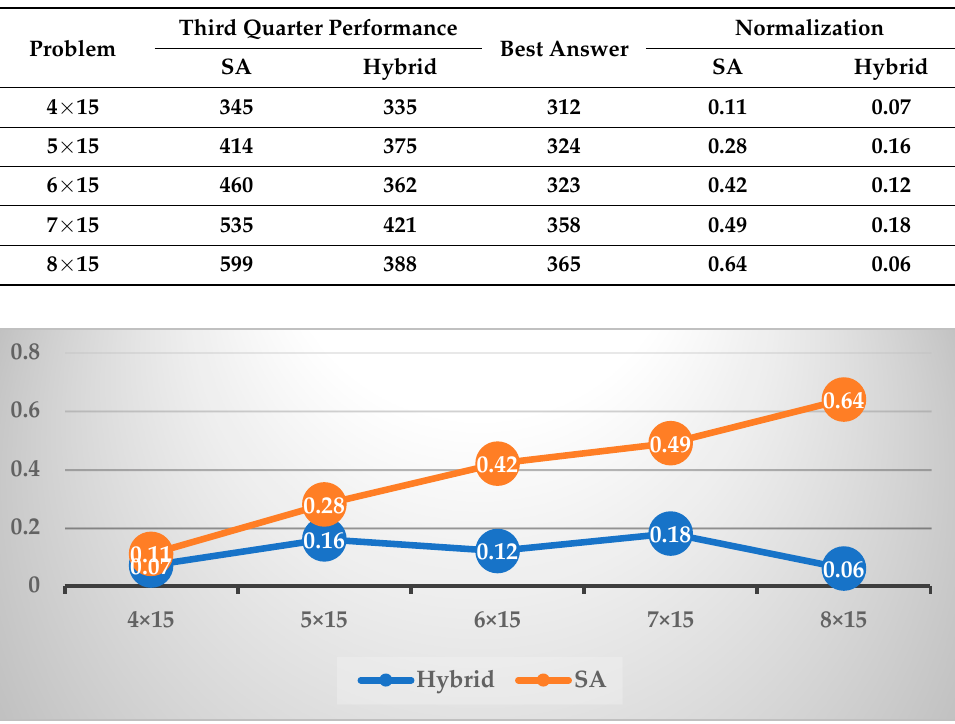
Figure 18. Fitness diagram of SA and hybrid SA in the third quarter (15 ORs). Table 9. Results of executing the SA and hybrid SA algorithms in the fourth quarter (10 ORs) .